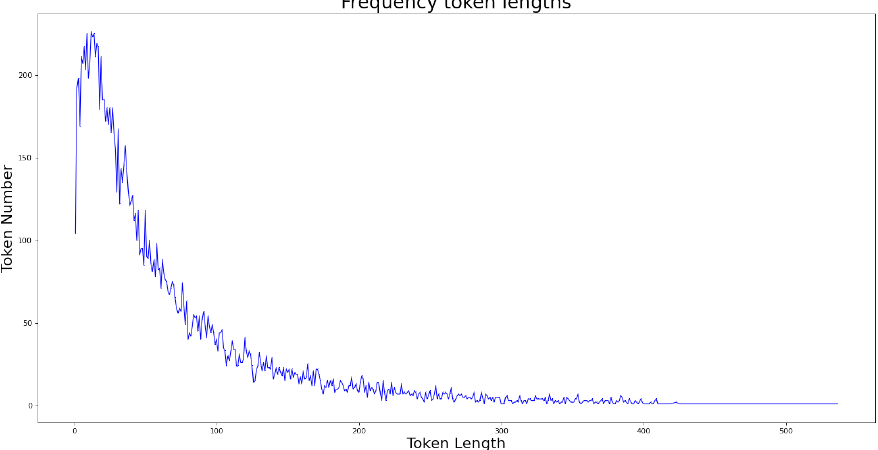
Figure 3. Frequency of the number of sample tokens with ten authors from the Islamic Network Forums